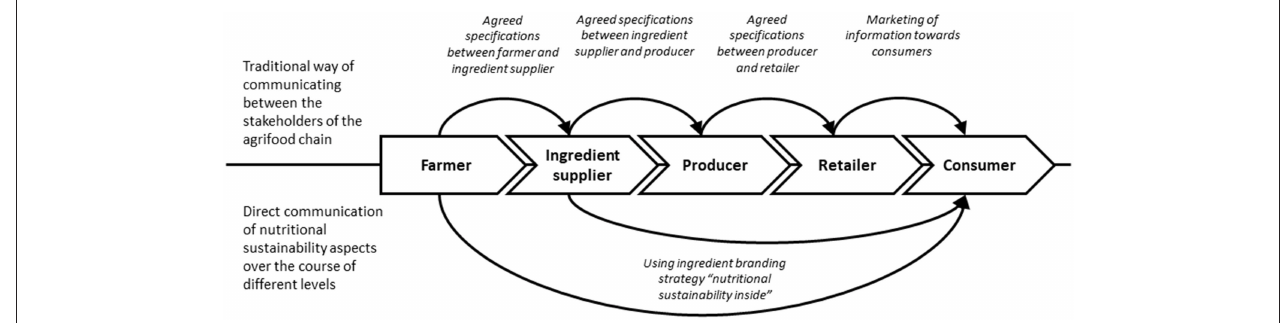
FIGURE 1 | Main ways of communicating nutritional sustainability aspects along the agrifood